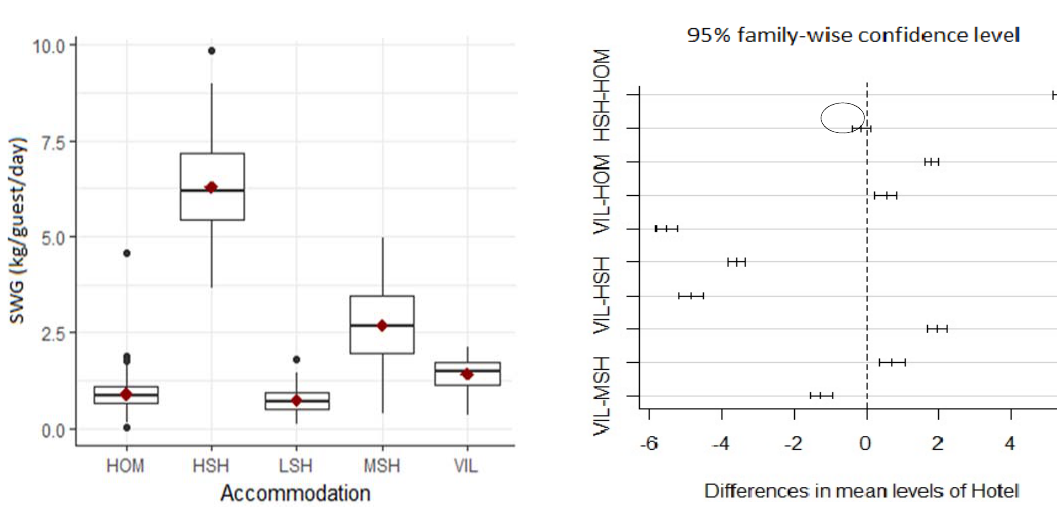
Fig. 3: Boxplot of Solid waste generation rate Fig. 4: The difference in solid waste generation rate of the hotel pairs